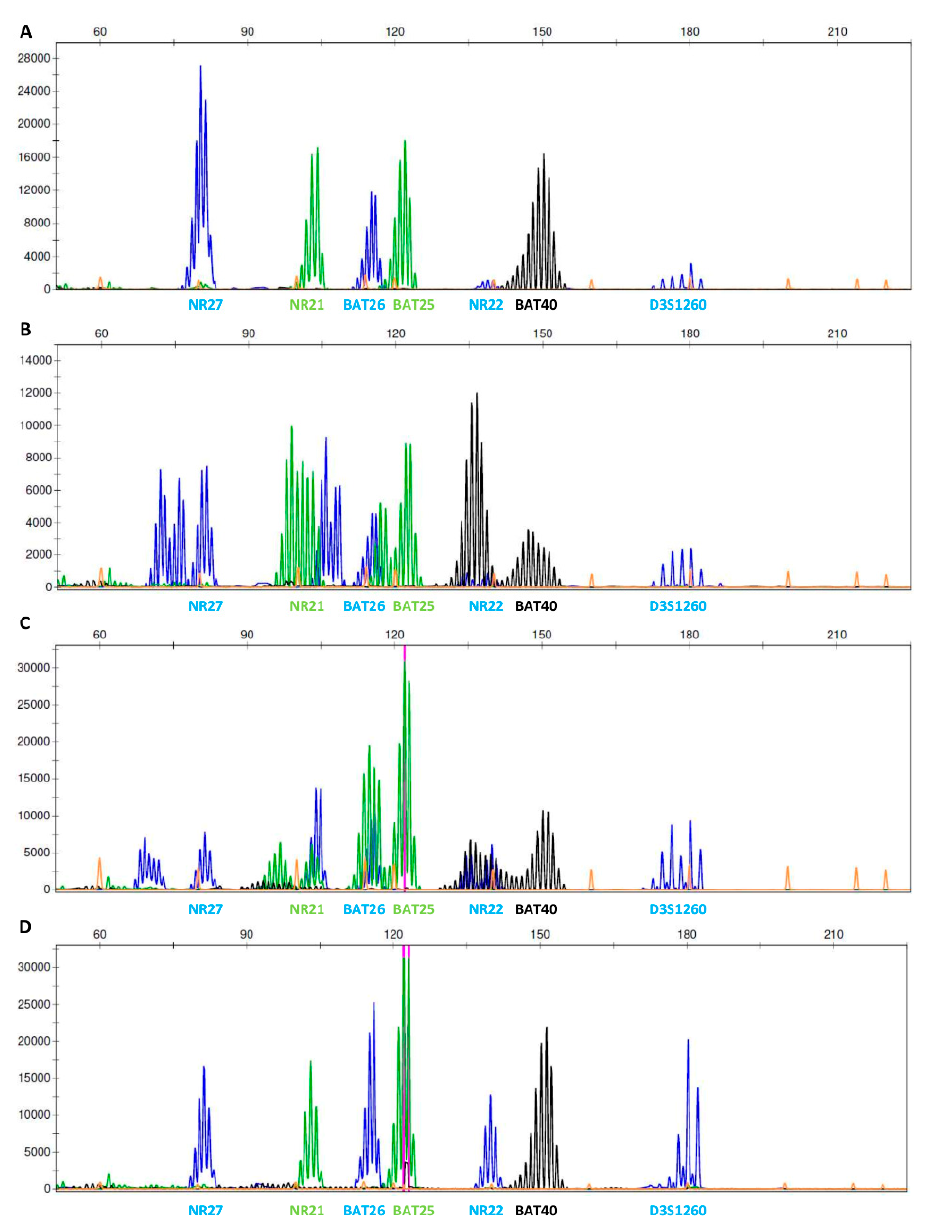
Figure 4. Microsatellite instability (MSI) of proband’s (III-1) tumor sample; adenocarcinoma of the cecum, detected by fragment analysis. ( A ) Negative control sample. ( B) Positive control sample. ( C ) Proband’s tumor sample with MSI-high status. ( D) Proband’s non-tumor (blood) sample with MSI-stable status. Note, we detected six mononucleotide repeat markers: BAT25, BAT26, BAT40, NR21, NR22, and NR27, and one polymorphic dinucleotide marker as internal control D3S1260.